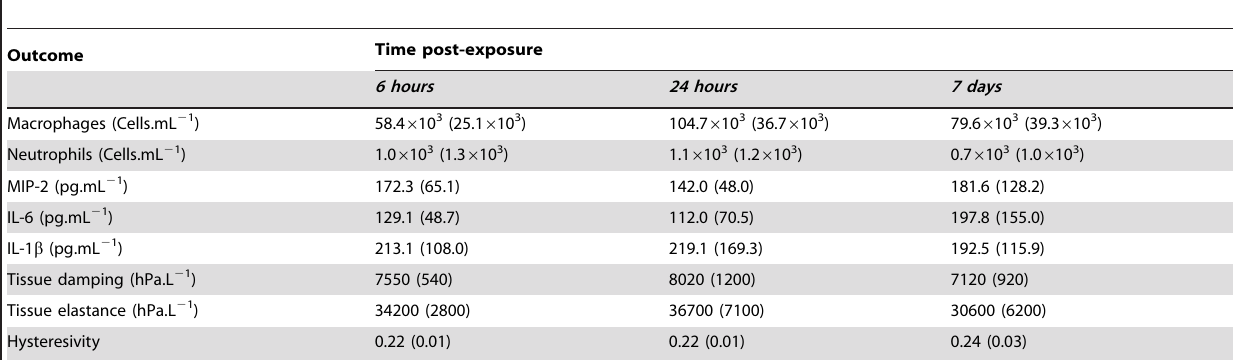
Table 3. Results for control (saline exposed) mice for the outcome measures of interest 6 hours, 24 hours and 7 days post-